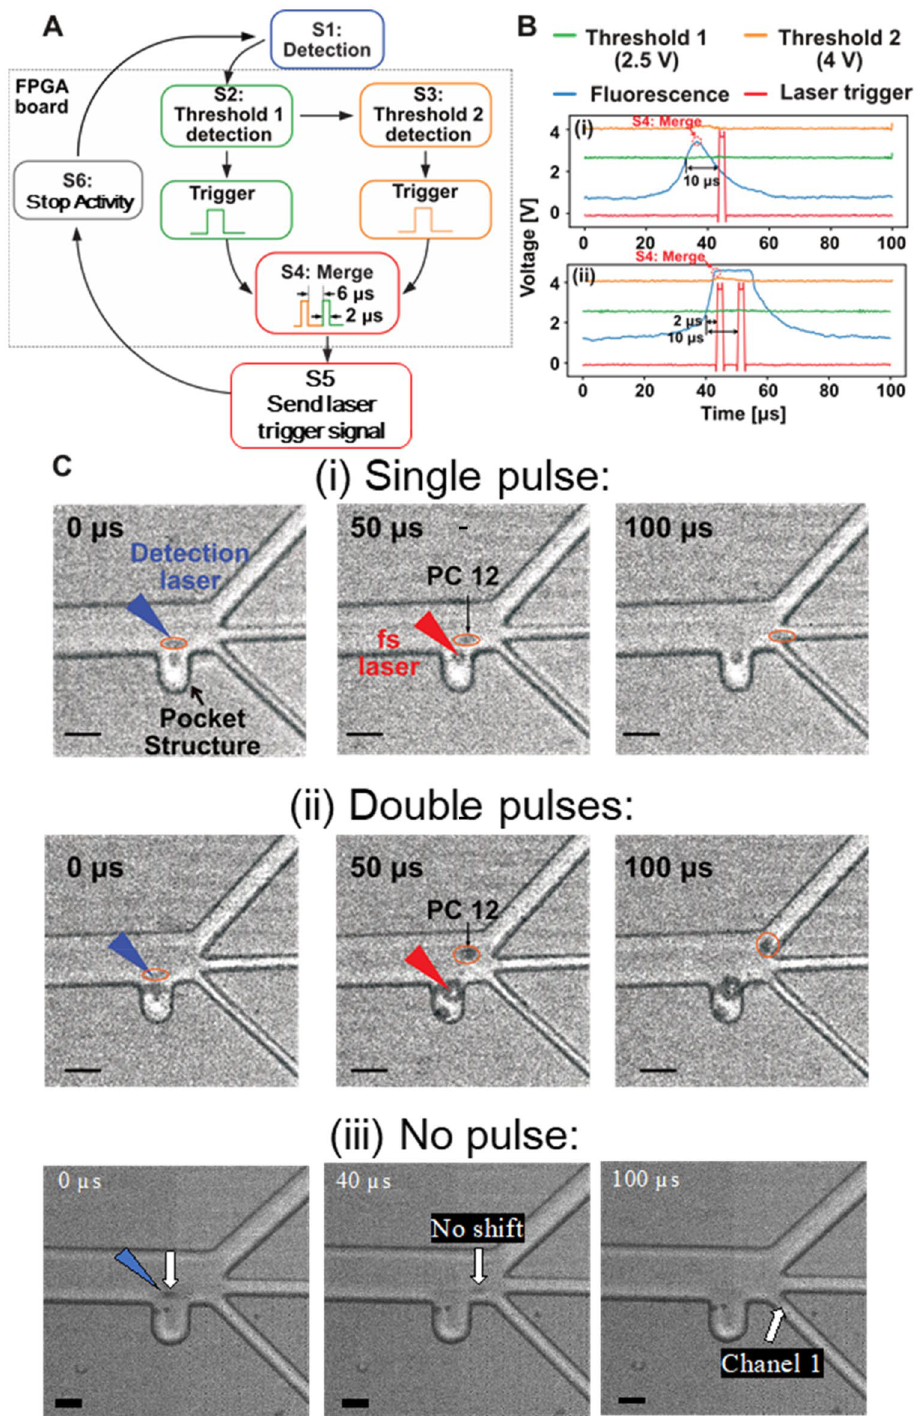
Figure 2. Demonstrations of cell sorting by pulse control. ( A ) Schematic of the intensity discrimination. ( B ) Oscilloscope illustrations showing the fluorescence signal and laser trigger signal in the case of (i) a single pulse and (ii) double pulses. ( C ) Experimental results for PC-12 cells in the case of (i) a single pulse, (ii) double pulses, and (iii) no pulse. The scale bars represent 40